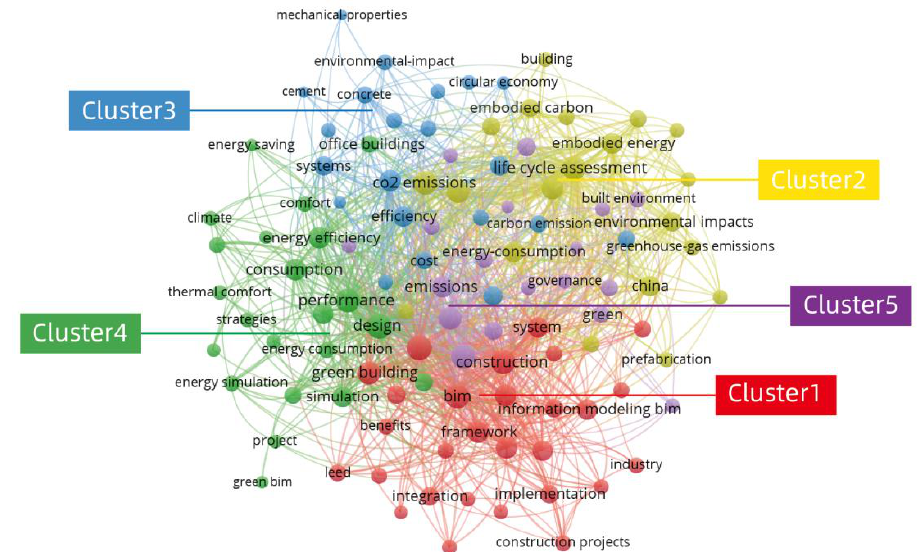
Figure 4. Keyword-network visualization of published articles regarding BIM in the field of carbon emissions for sustainable buildings from 2008 to 2021 (14 years) via VOSviewer software (generated by the authors).